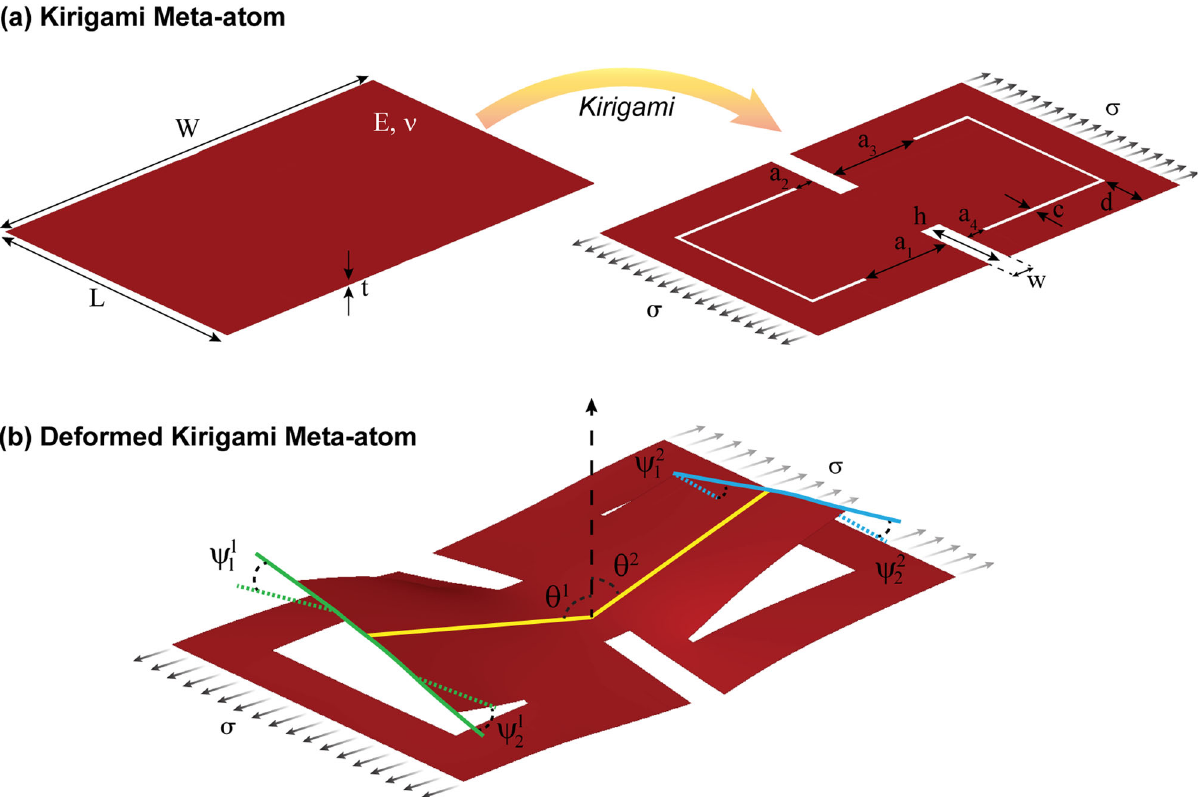
Fig. 1 Kirigami meta-atom template. a Initial Kirigami canvas and canvas with interior cuts. b Deformed Kirigami with relevant deformation